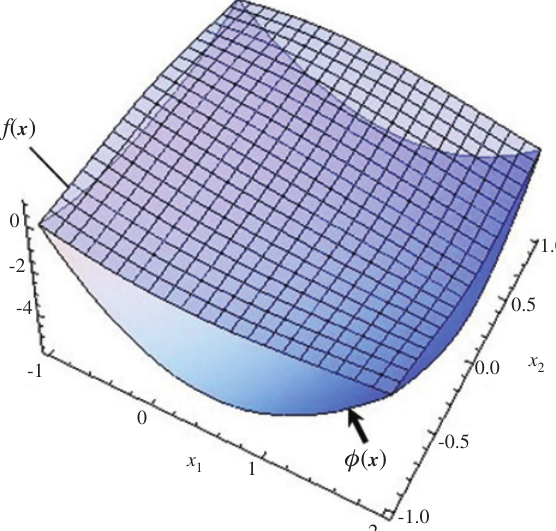
Figure 7: Trigonometric underestimator for a generalized polyno- mial function in Example 7.